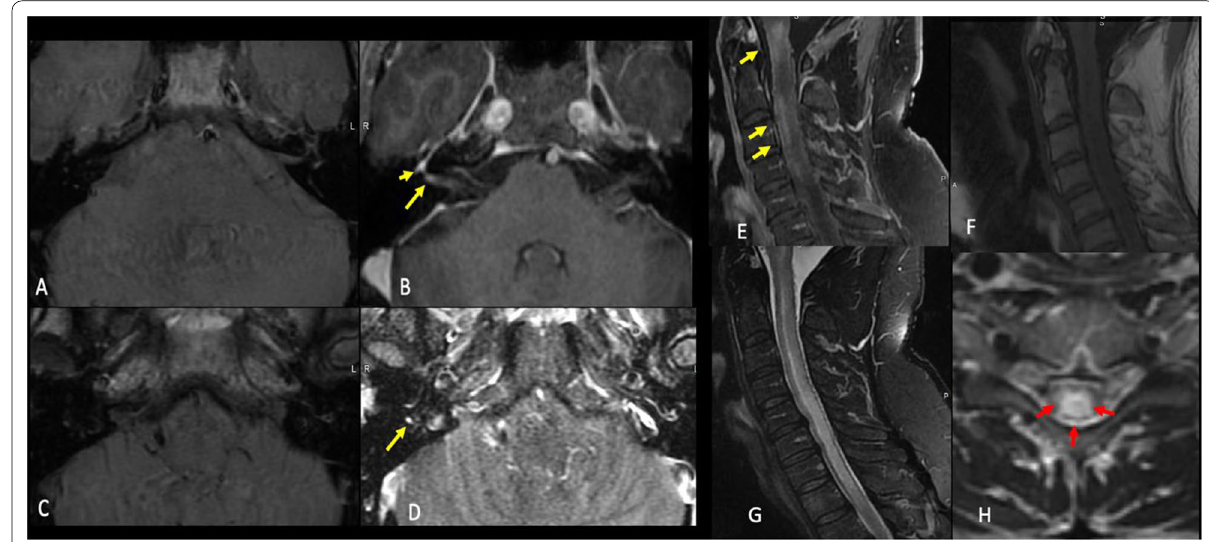
Fig. 5 Neuroimaging features after COVID-19 vaccination. Case 1: A 46-year-old-man who presented with a rapid onset right-sided facial weakness after having COVID-19 vaccine. Axial T1 pre ( a and c ) and T1 postcontrast fat sat ( b and d ) demonstrate abnormal enhancement of the right facial nerve within the lateral right IAC (long yellow arrow in b ) as well as asymmetric enhancement of the right geniculate ganglion (short yellow arrow in b ) and tympanic portion of the facial nerve (yellow arrow in d ). Findings are consistent with Bell’s palsy. Case 2: A 51-year-old-man who presented with a sudden upper and lower limb weakness after having COVID-19 vaccine. Sagittal T1 postcontrast ( e ) T1 pre ( f ), STIR ( g ), and axial T2W ( h ) images demonstrate extensive T2 signal hyperintensity of the central cervical cord (red arrows) with patchy areas of enhancement at the levels of c1, c2, c3 and c4 (yellow arrows). There was no associated restricted diffusion. Findings were consistent with transverse